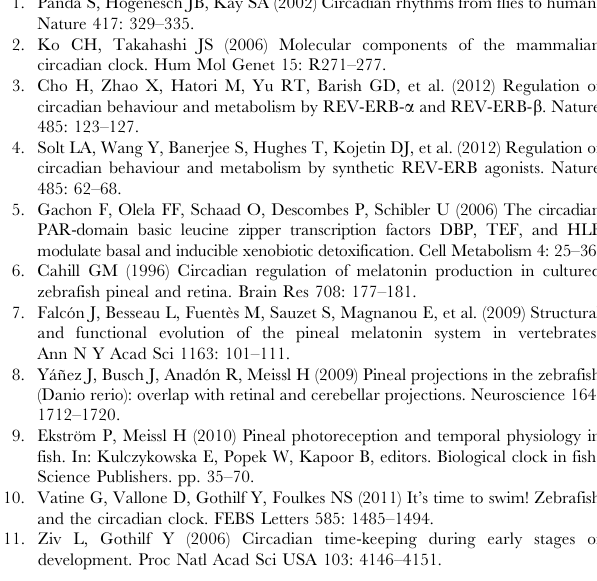
Figure S8 True-positive rate as a function of the number of circadian transcripts detected. A) DNA microarray experiment and B) RNA-Seq experiment. Red circles mark the size of the chosen list of transcripts. Table S1 List of circadian genes using DNA Microarray. Table S2 List of circadian RefSeq genes using RNA-seq. Table S3 Known zebrafish genes that form the core clock. The temporal pattern of each gene, as determined using RNA-seq, is compared to previously reported experimental data. Table S4 Known zebrafish clock-controlled genes that are considered to form accessory loops of the molecular circadian oscillator. The temporal pattern of each gene, as determined using RNA-seq, is compared to previously reported experimental data. Table S5 DAVID analysis of gene functional annotations. Table S6 DAVID analysis: a) genes that belong to the glycolysis pathway and b) genes that belong to the oxidation-reduction